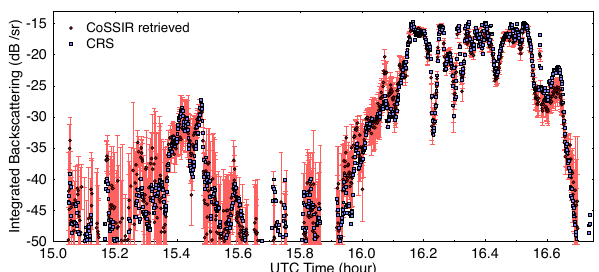
Fig. 8. CoSSIR retrieved nadir viewing vertically integrated 94GHz backscattering (with error bars) and integrated backscattering from the 94GHz Cloud Radar